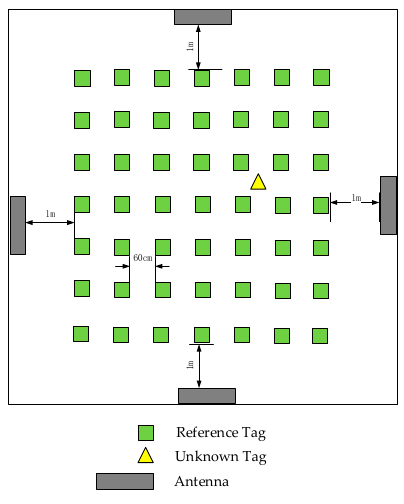
Figure 4. Device placement scenario.